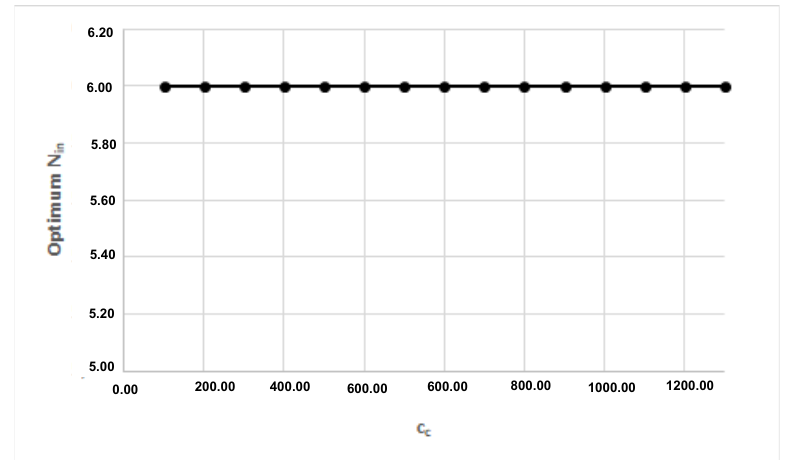
Figure 16. Variations of optimum N in per c c .